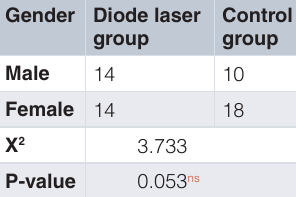
Table 2. Gender distribution of participants.